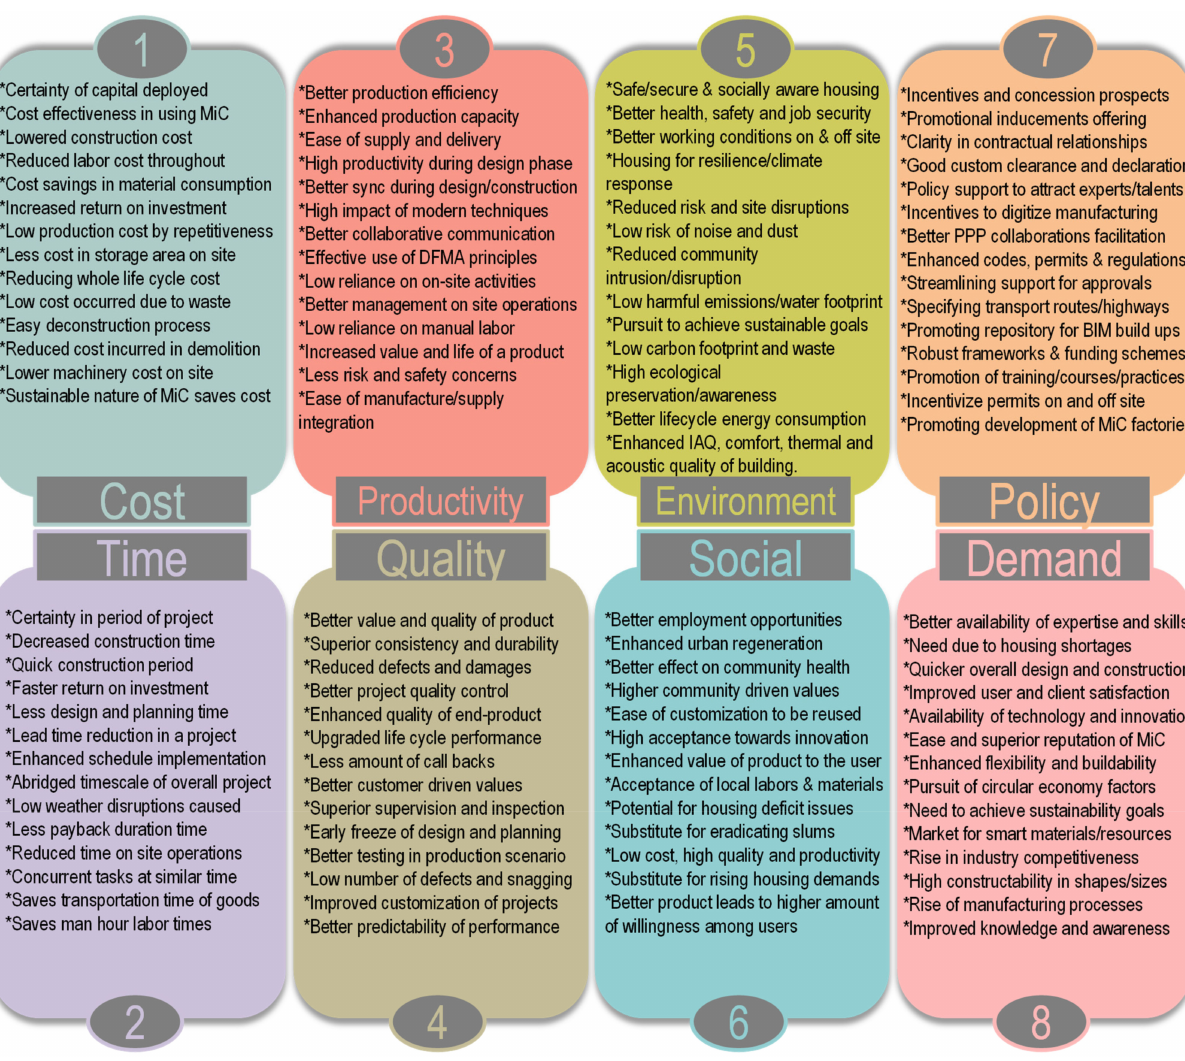
Figure 6. List of drivers grouped in